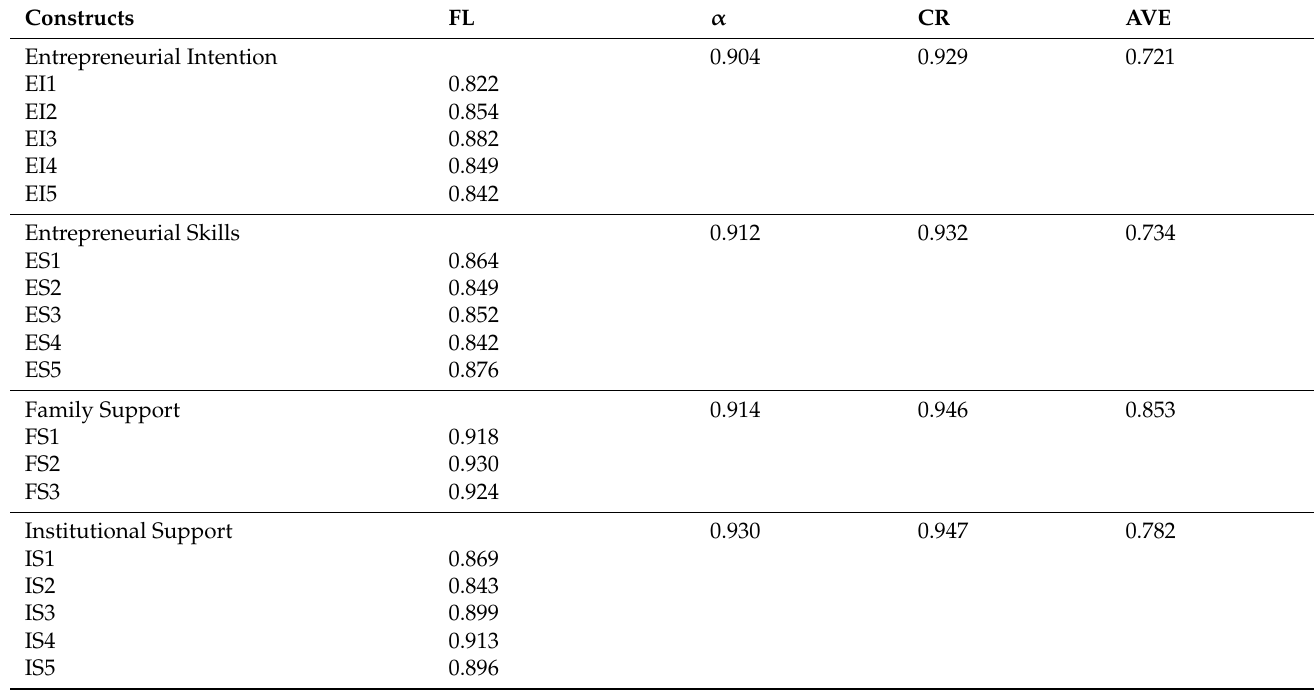
Table 2. Measurement model (FL, α , CR, and